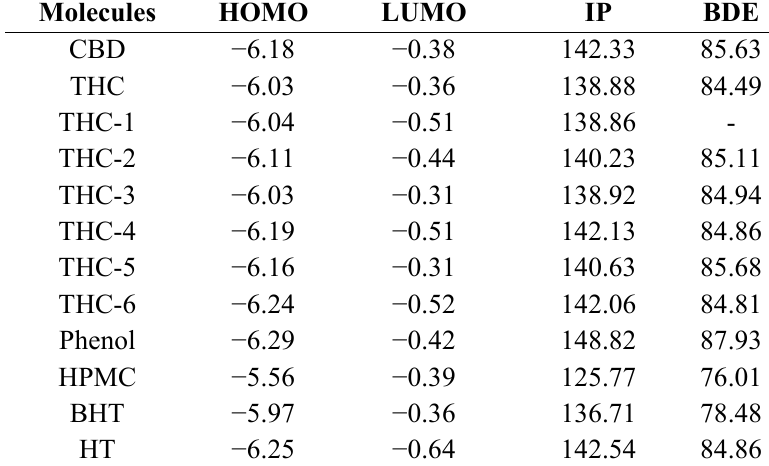
Table 1. Frontier orbital energies (HOMO and LUMO, in eV), ionization potential (IP, in kcal mol − 1 ) and the O-H bond dissociation (BDE, in kcal mol − 1 ) of the